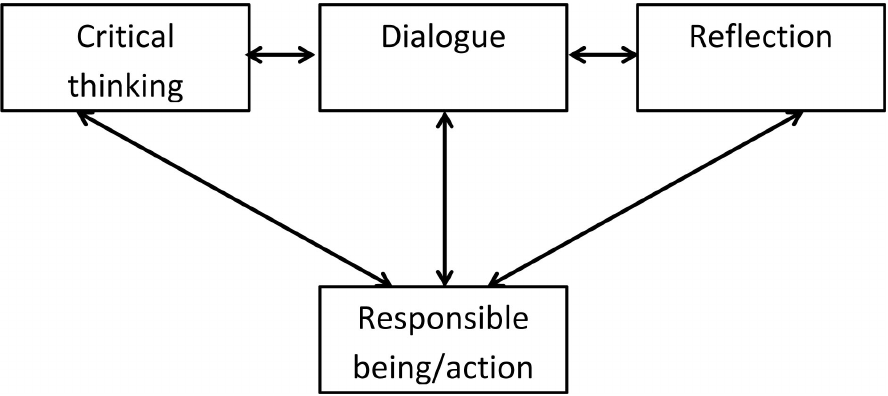
Figure 1: Critical global citizenship education framework Critical